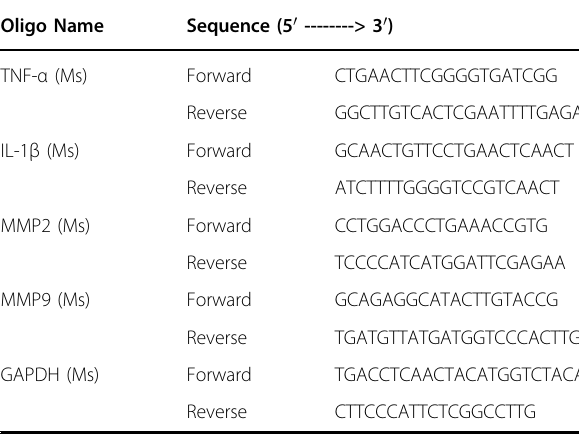
Table 1 Primer sequences of quantitative reverse transcription-polymerase chain